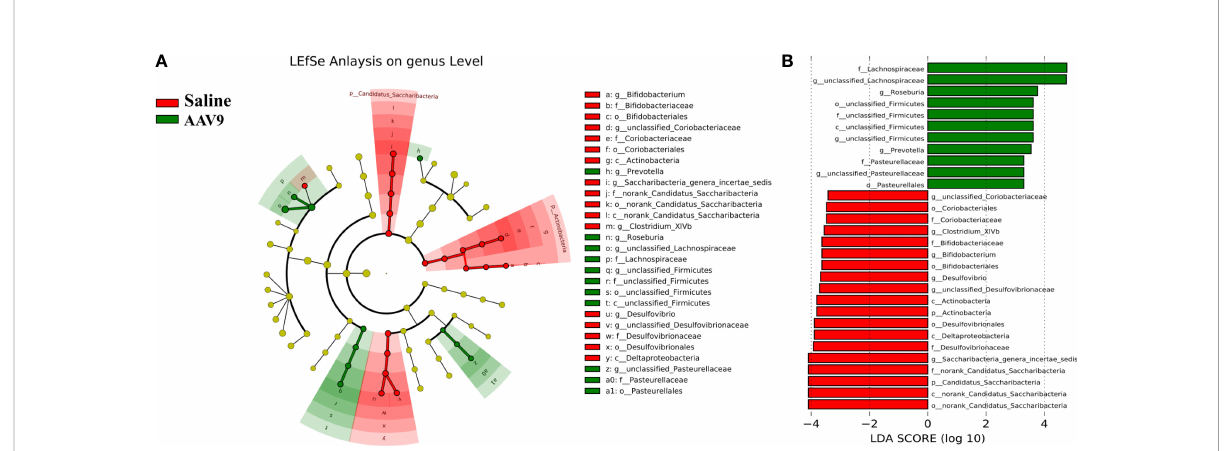
FIGURE 6 Comparative LEfSe analysis of microbial abundance at the genus level between the two groups. (A) LEfSe analysis at the genus level. The green node represents the relatively higher abundance of bacteria at this level in the AAV9 group; the red node represents the higher abundance of bacteria at this level in the saline group. (B) Linear discriminant analysis (LDA) score identifying differentiating biomarkers between the two groups with a threshold score of